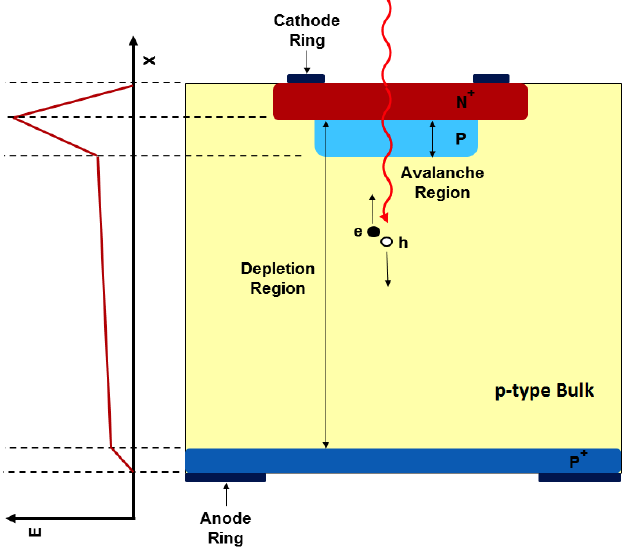
Fig. 5: View of the cross section of an LGAD